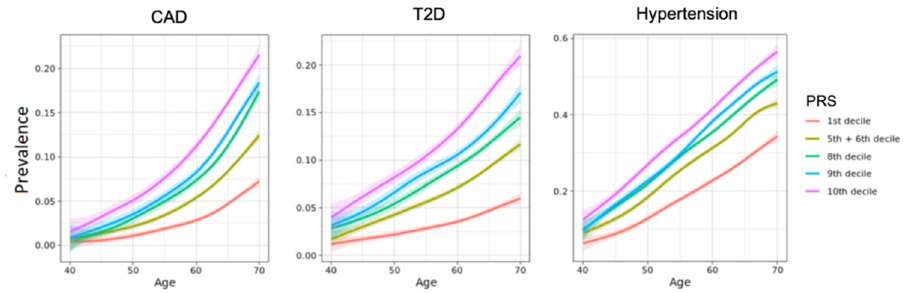
Figure 2. Cumulative incidence in different risk strata. Risk classification conducted based on the logistic regression model of the PRS adjusted for age, sex, first four principal components, and array type.